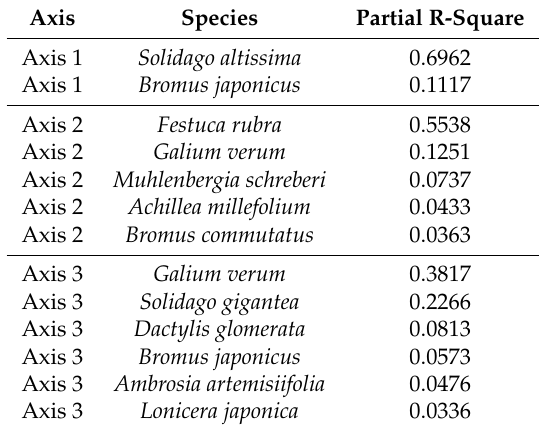
Figure 6. Non-metric multidimensional scaling (NMS) ordination results using species composition from Lake Arnold (LA), northeast boundary (NEB), northeast early (NEE), and southwest early (SWE) fields at the Blandy Experimental Farm in northern Virginia for ( a ) axes 1 and 2; ( b ) axes 1 and 3; and ( c ) axes 2 and 3. Table 2. Stepwise regression results on which species most influence non-metric multidimensional scaling (NMS) ordination axes. Enough species were retained to have a cumulative R 2 of 0.80. All species indicated here are significant to p <